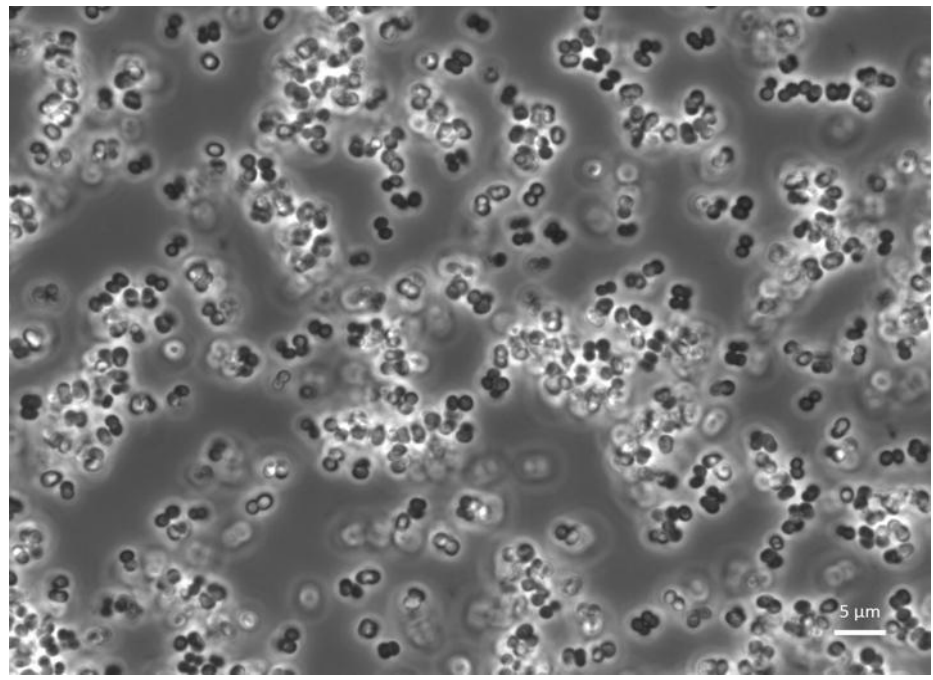
Figure 2. Confocal microscopy observation of Pediococcus pentosaceus KVBL 19-01. Probiotic activity of the strain has been recorded on T. molitor by Lecocq et al. [78].